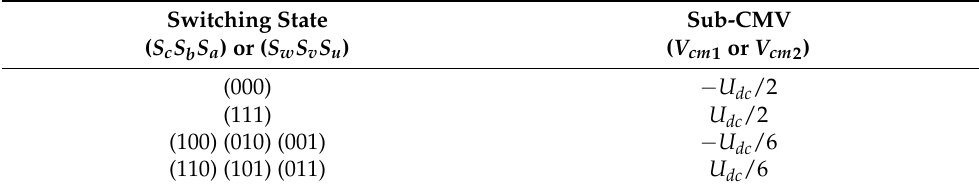
Table 2. As can be seen from (3), the total CMV is determined by the combination of two sub-CMVs. Therefore, the possible values of total CMV can be obtained, as shown in Table 3. Table 2. CMV values generated by three-phase windings.